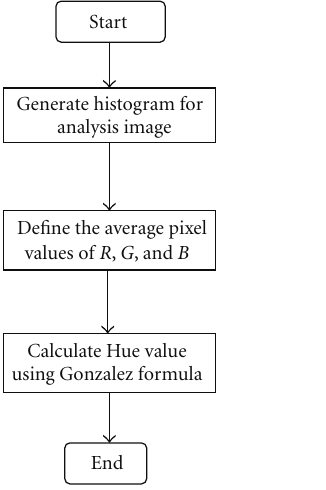
Figure 2: Flow chart for calculating the Hue digital value.